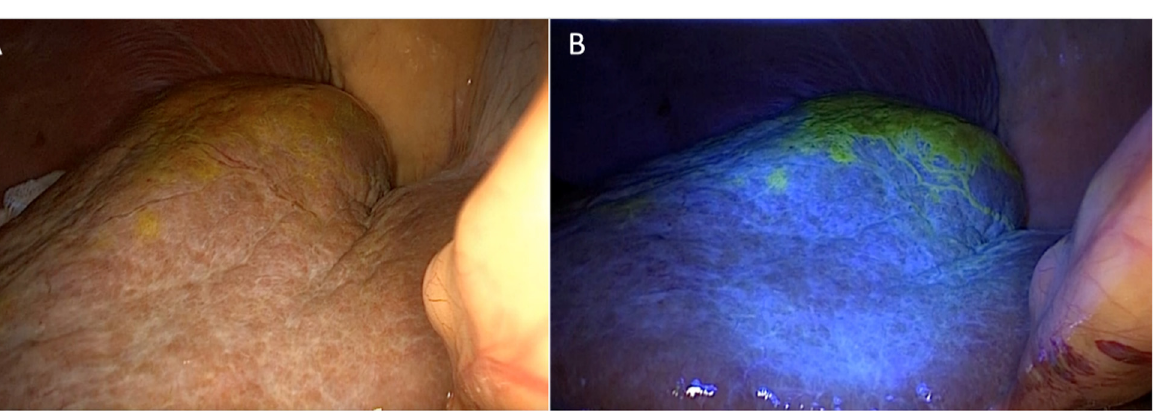
Figure 4. Laparoscopic liver resection using intervention-guided fluorescence imaging technique. ( A ) No fluorescence appeared on the liver surface without blue light. ( B ) Hepatic segment 7 fluoresced under blue light (same case as shown in Figure 1).